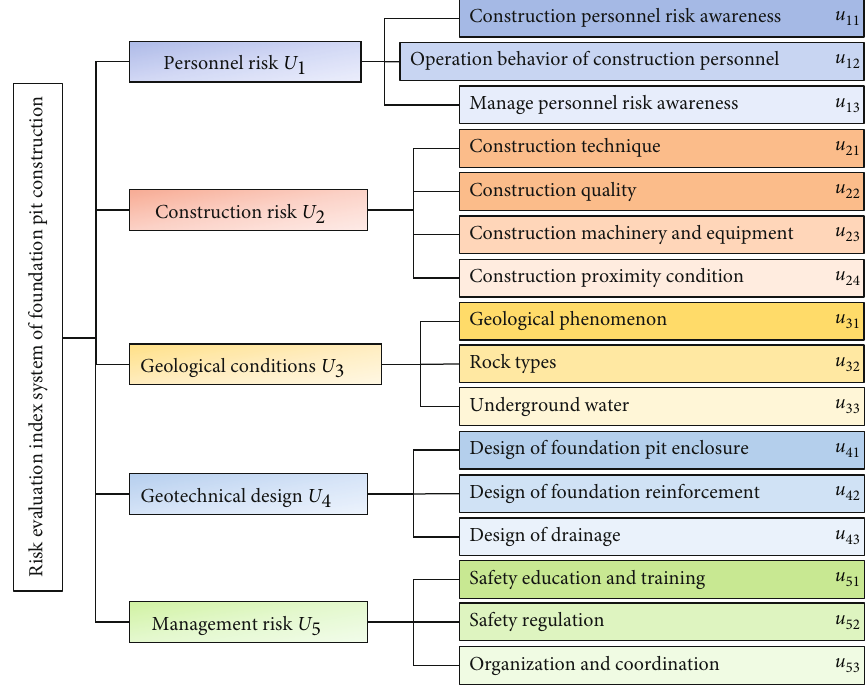
Table 7: Rating scale (expert E